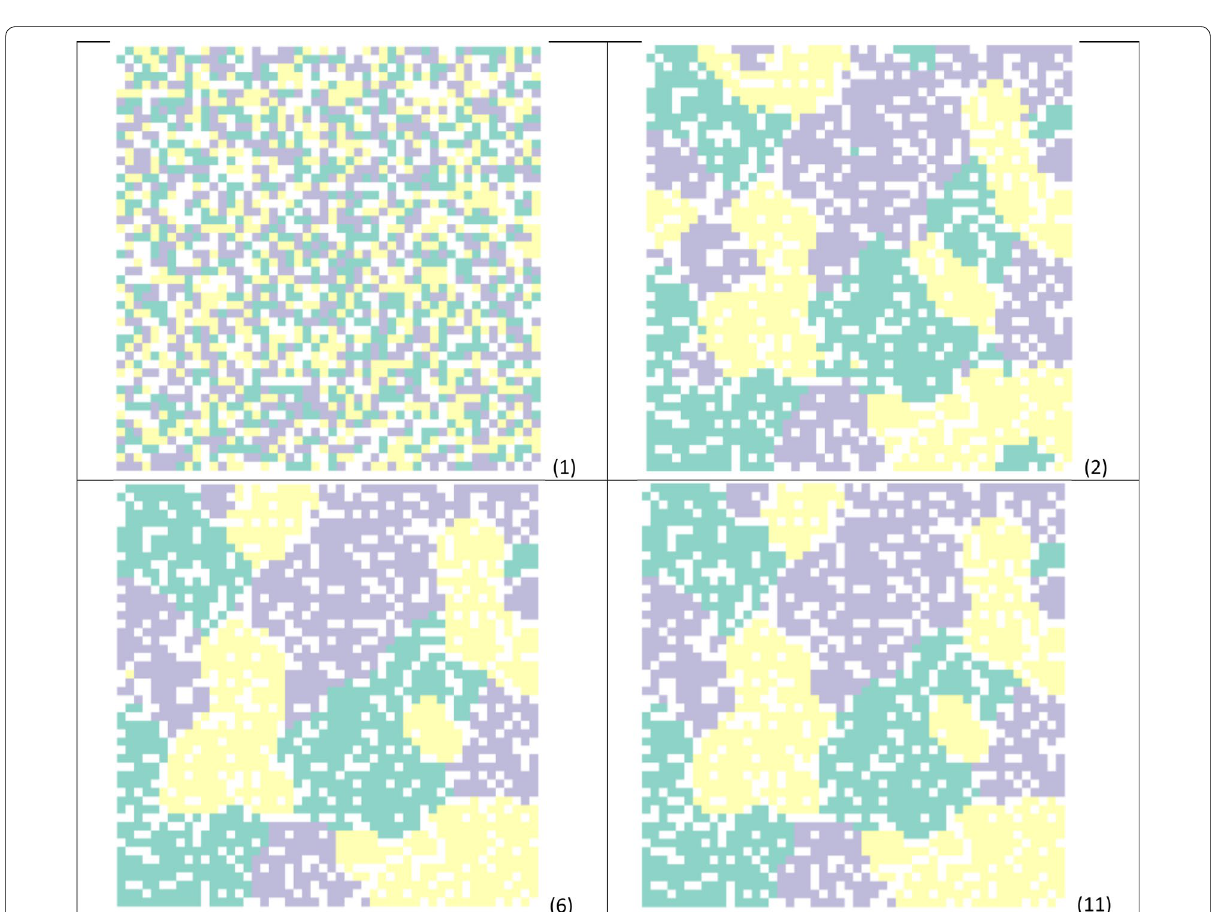
Fig. 2 Illustration of one simulation run for scenario 1 on a 50 this two-agent interaction scenario, the simulation terminates quite nicely at a stationary